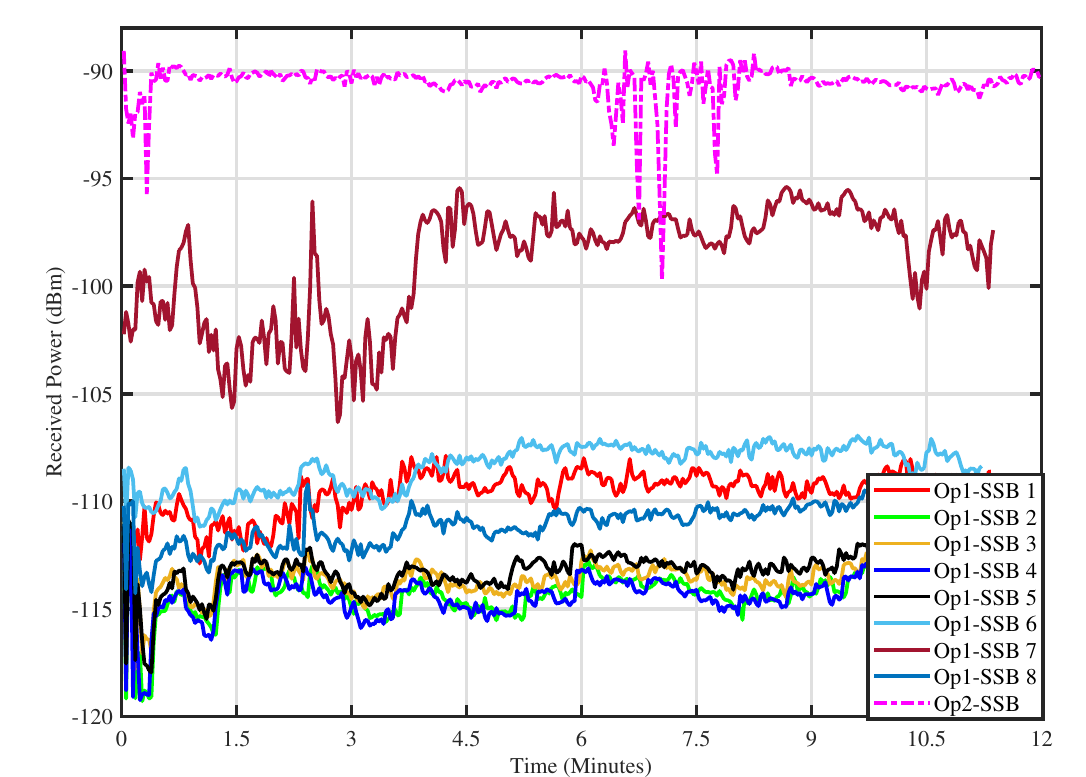
Figure 4. Received power of the detected SSBs for Op1 (multiple SSBs) and Op2 (single SSB) over time at Location